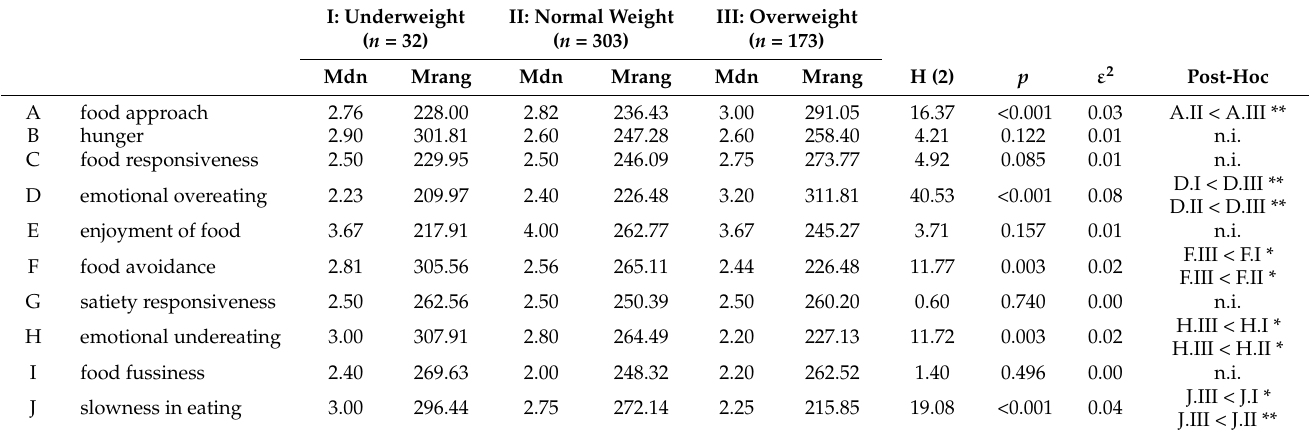
Table 10. Results of between-group comparison using Kruskal–Wallis H test, along with post hoc tests on AEBQ-questionnaire dimensions and BMI